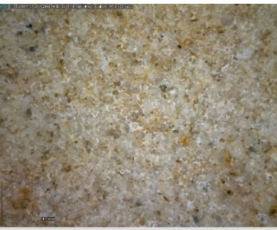
Figure 5. Hoˇrice sandstone DinoLite microscope image, magnification 50 × .